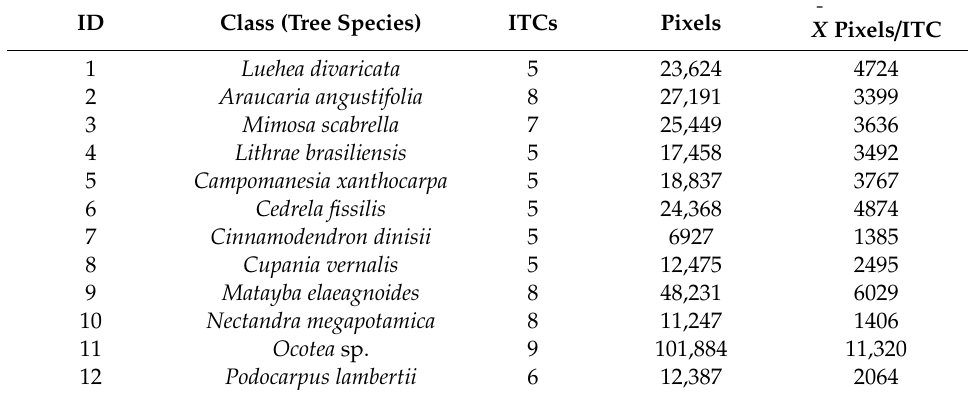
Table 1. Species list, number of individual tree crowns (ITCs), pixels, and average pixels per